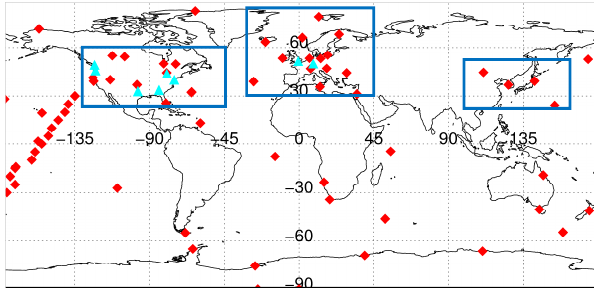
Figure 3. Locations of the surface stations (red diamonds) and MOZAIC airports (turquoise triangles) used for the model evalu- ation. Selected evaluation regions are marked with blue